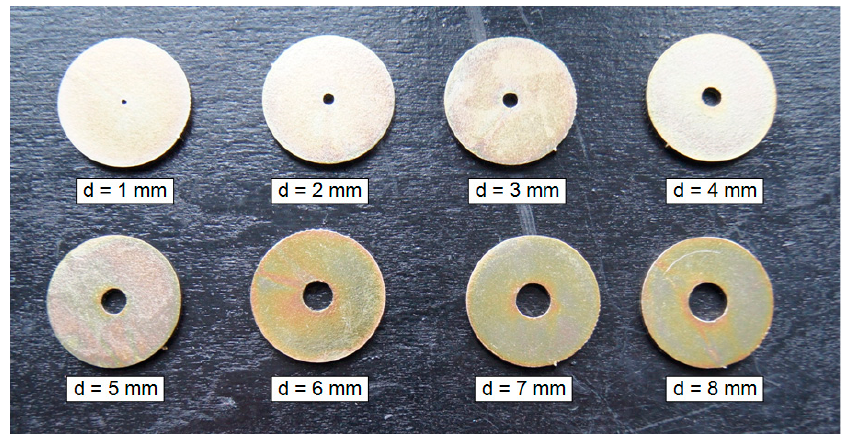
Figure 2. Discs with holes of different diameters.